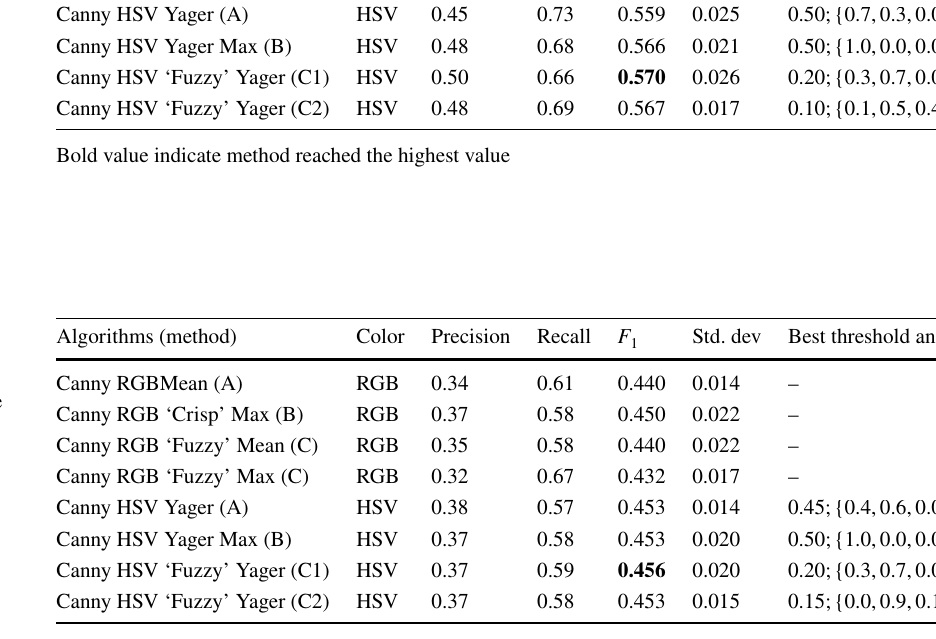
Bold value indicate method reached the